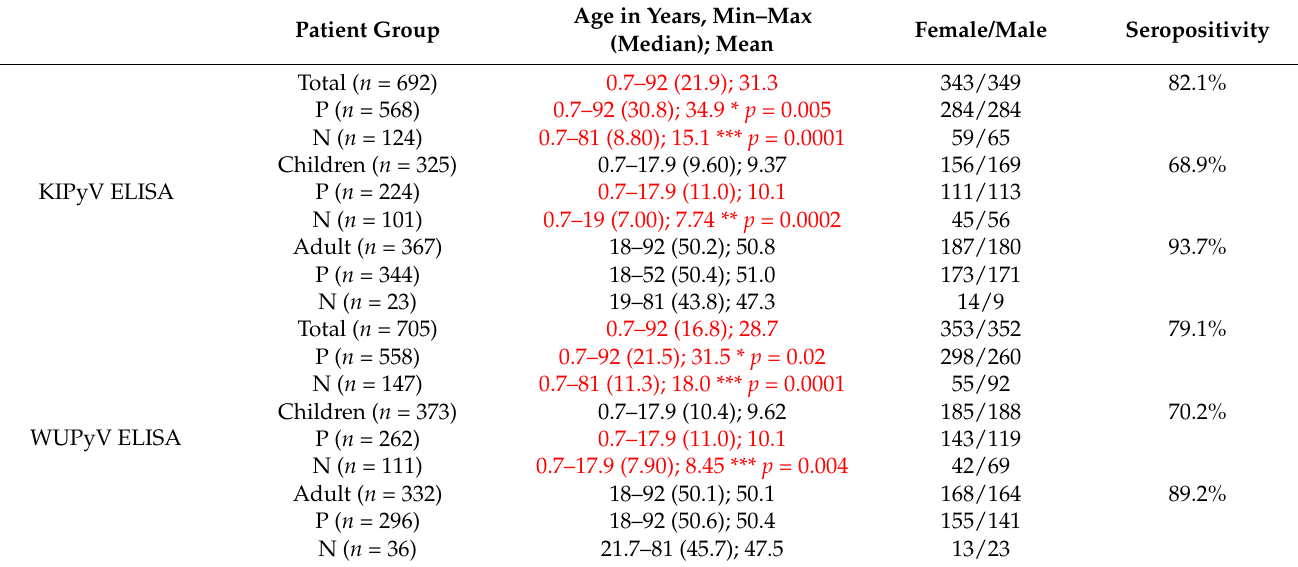
Table 2. Detailed data of patients seropositive and seronegative for WU and KI